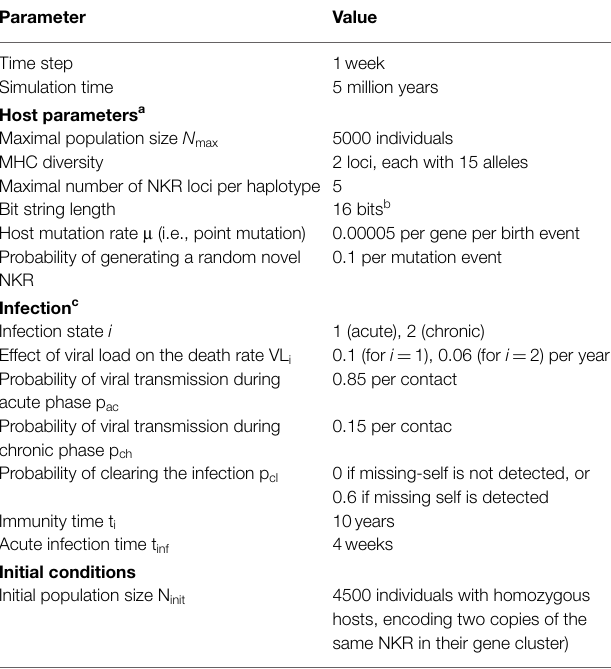
TABLE 1 | Parameters of the agent-based model